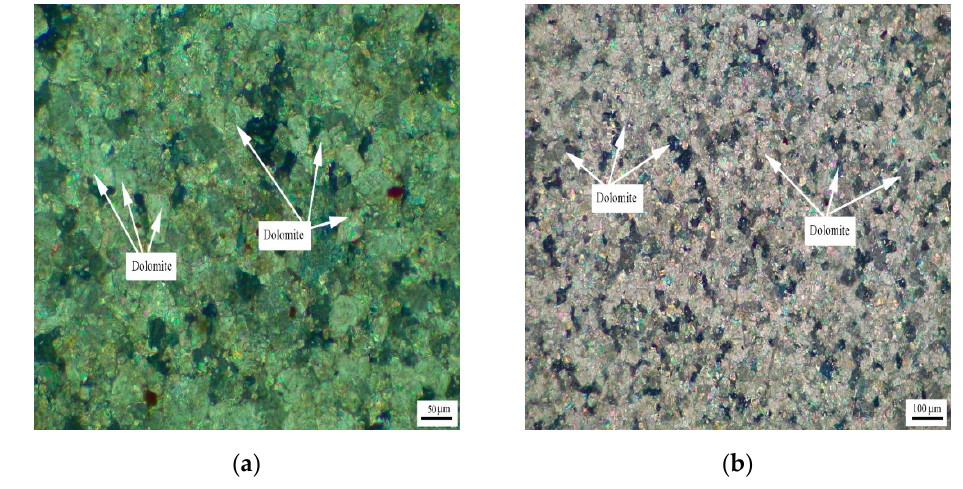
Figure 3. Distribution of dolomites in Jixianian rocks ( a ) WMS-6 and ( b ) WMS-8.